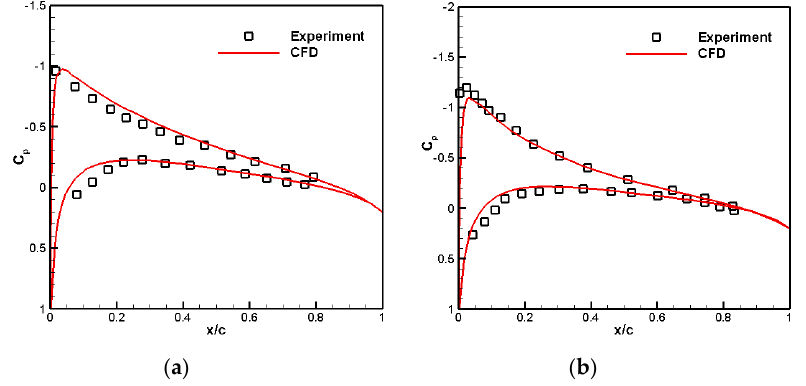
Figure 3. Chordwise pressure distribution on the rotor blade at a rotation speed of 1750 r/min: ( a ) r/R = 0.68; ( b ) r/R = 0.89.